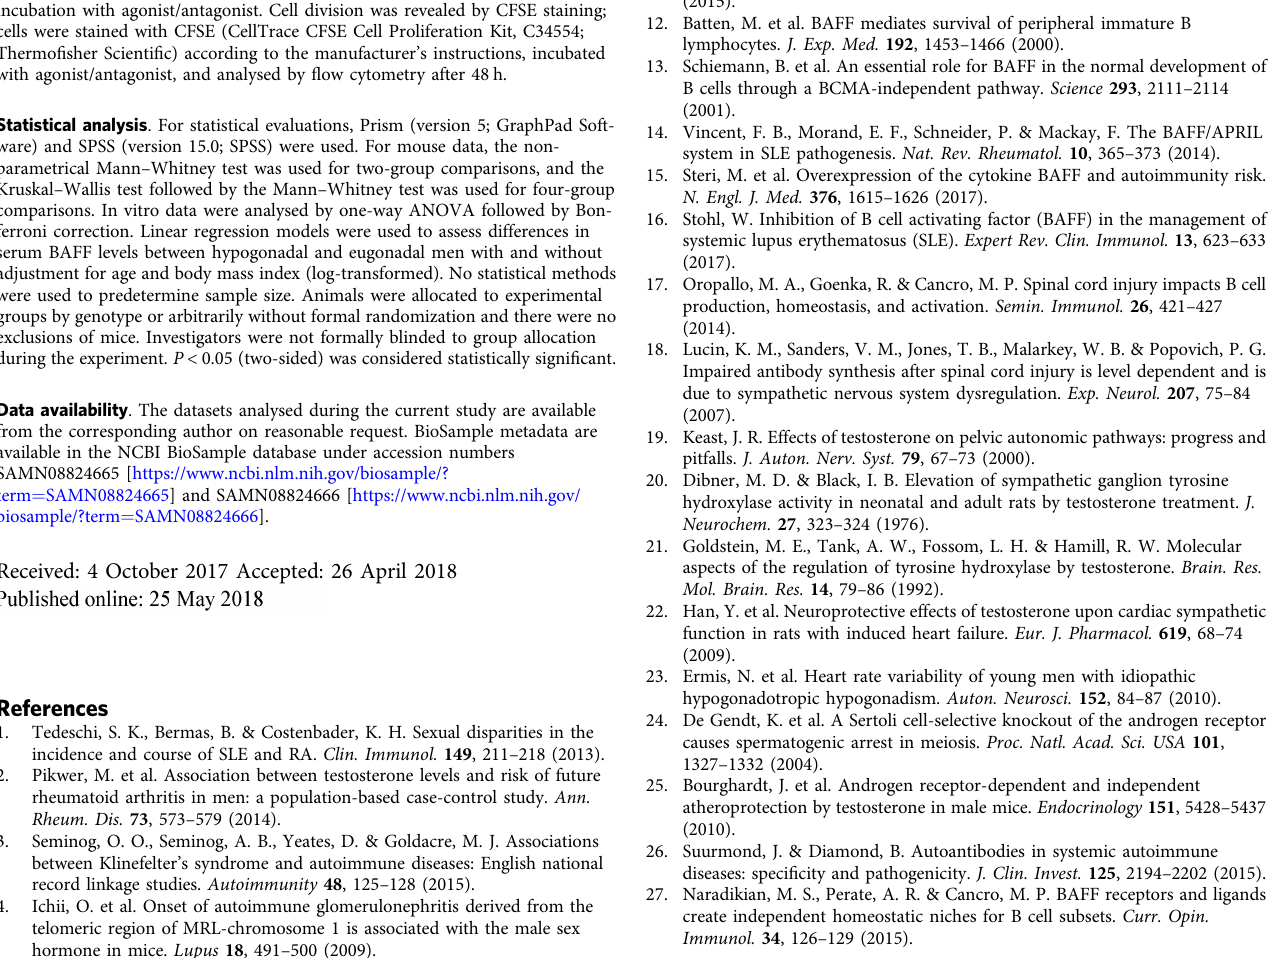
Fig. 6 α -Adrenergic manipulation regulates FRC numbers. a Transcripts per million (TPM) of all α - and β -adrenergic receptor and dopamine receptor family members in splenic fi broblastic reticular cells (FRC). Each splenic FRC sample ( n = 2) was generated by pooling lysed sorted cells from three independent sorts in which spleens from 5 to 10 male mice were combined. b α -Adrenergic receptor protein staining in FRCs analysed by fl ow cytometry. Percentages indicate proportion of FRCs staining positively for ADRA2B and ADRA1B, respectively. Data are from one experiment representative of two independent experiments. c Primary splenic stromal cell number after exposure to the α -adrenergic agonist phenylephrine (10 − 6 – 10 − 4 M) and/or the α -adrenergic antagonist phentolamine (10 − 7 – 10 − 5 M) for 48 h. Data were pooled from three and two separate experiments, respectively. d – g Proportion of annexin V